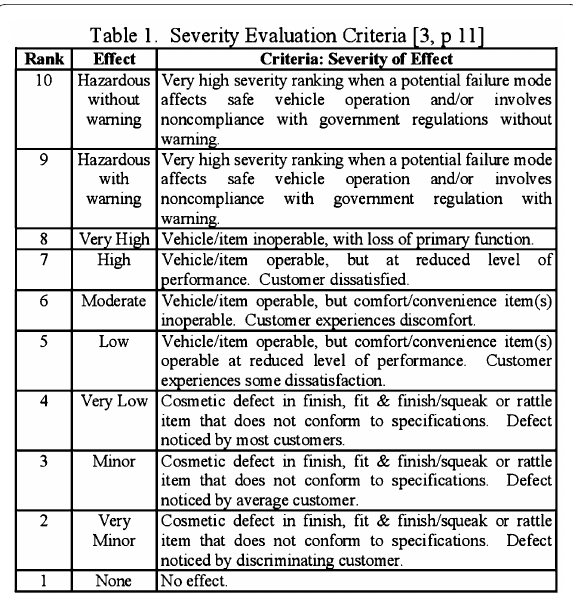
Figure 1 Example of severity value definition based on multiple criteria (adapted from